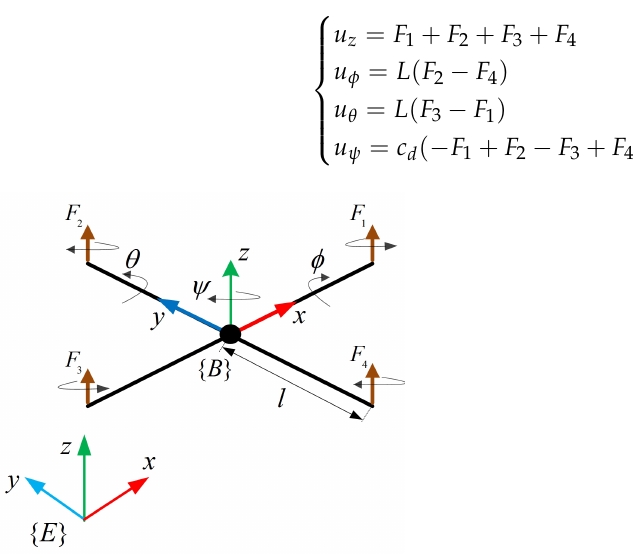
Figure 1. A typical quadcopter